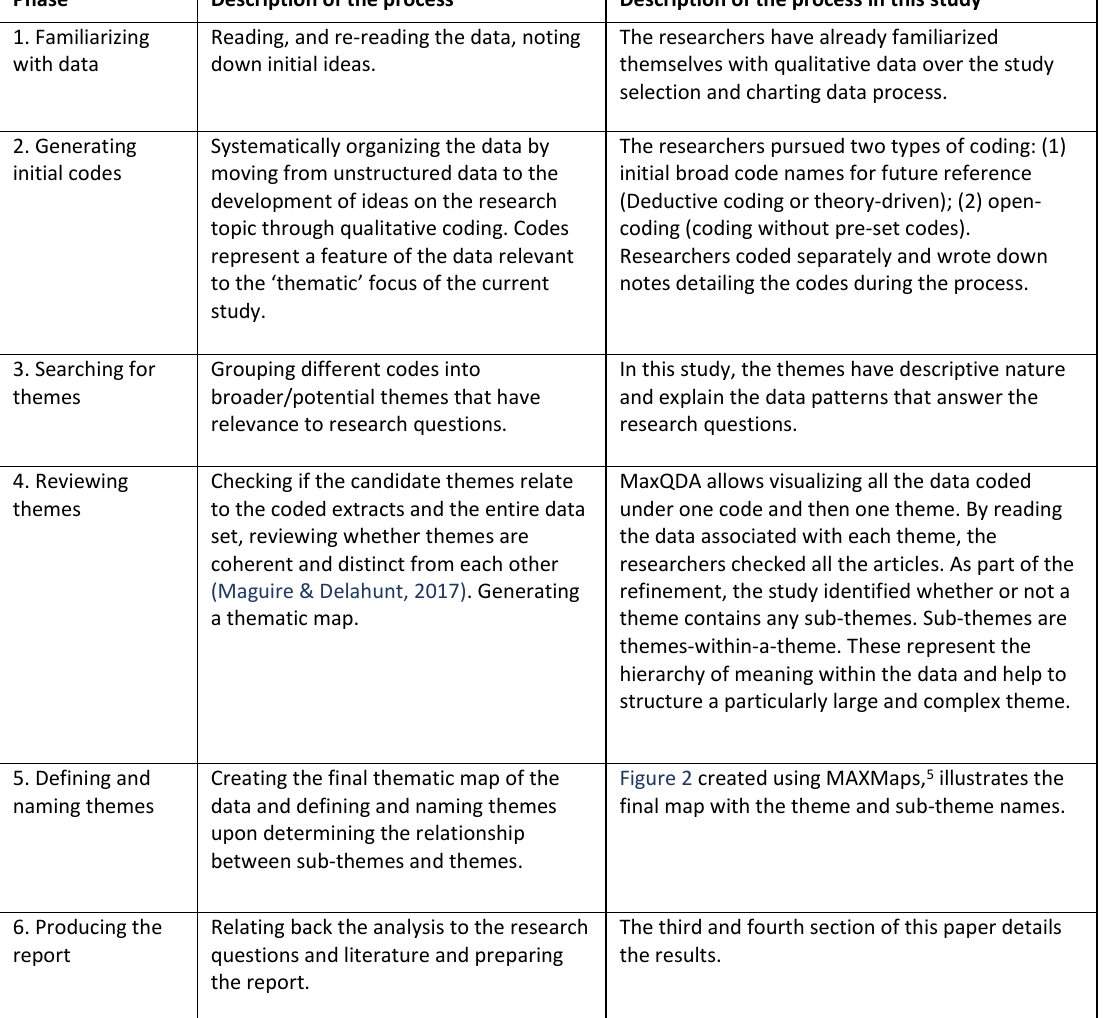
Figure 2 created using MAXMaps, 5 illustrates the final map with the theme and sub-theme